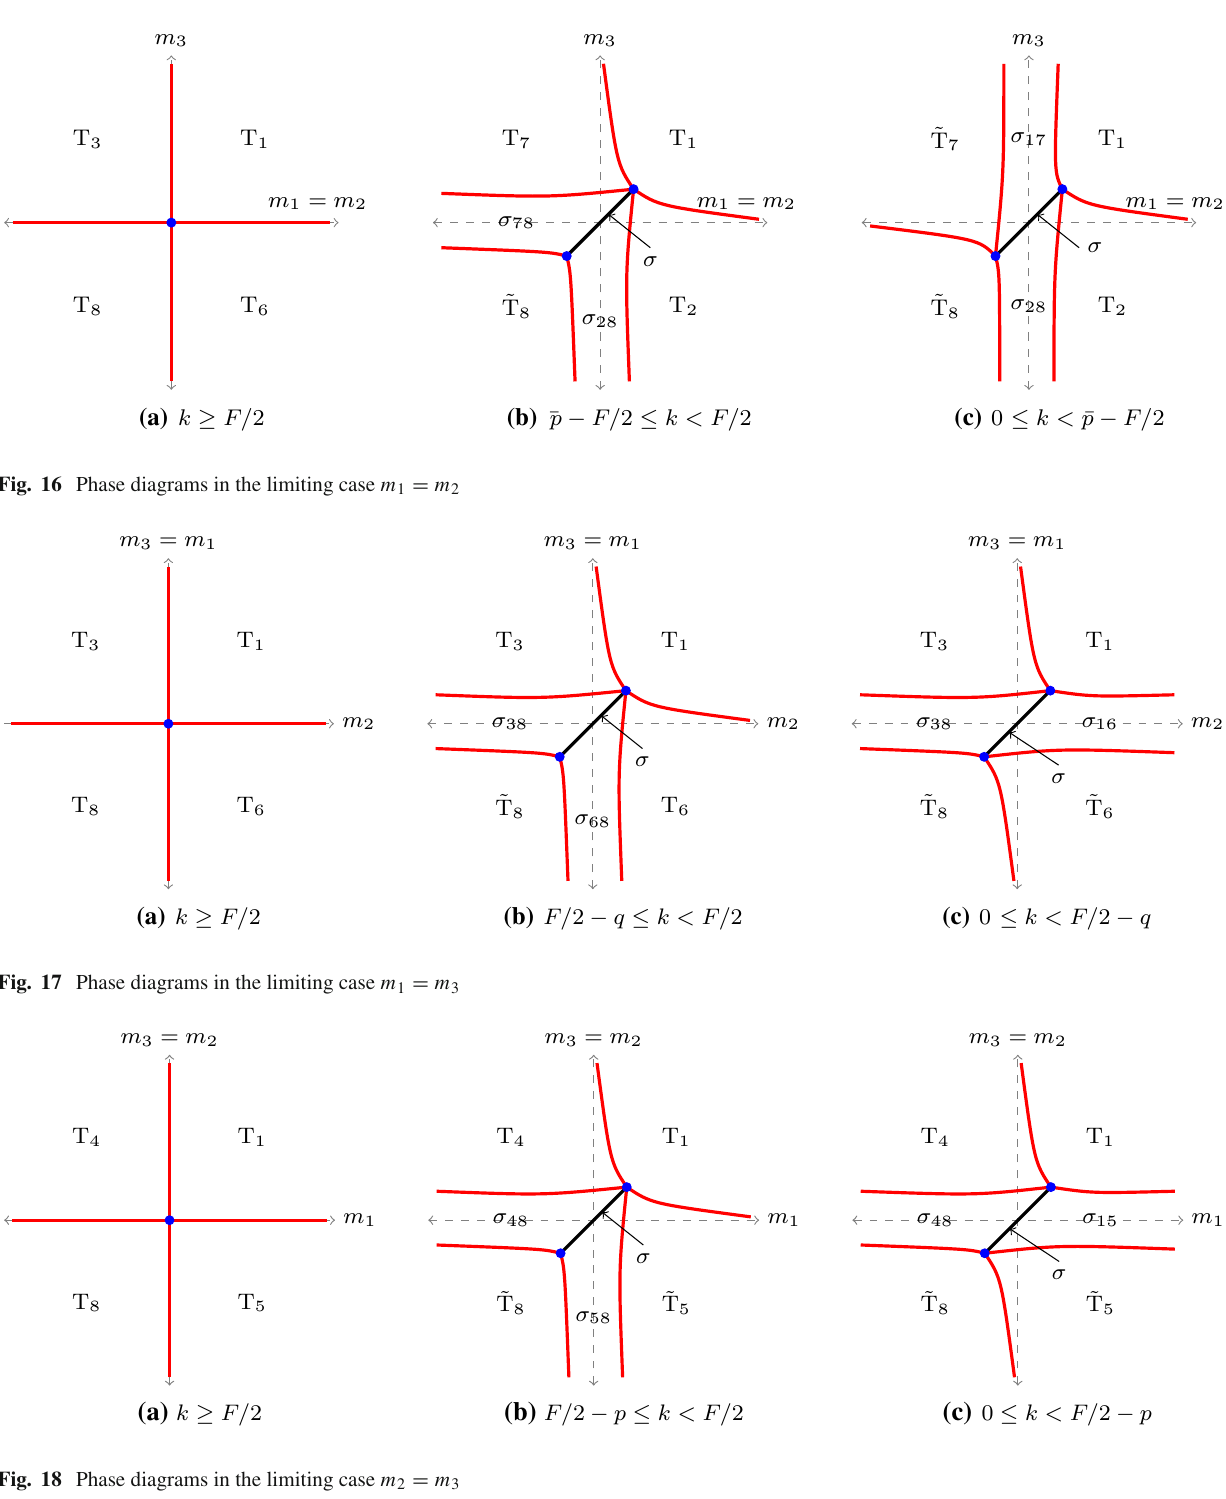
Fig. 18 Phase diagrams in the limiting case m 2 = m